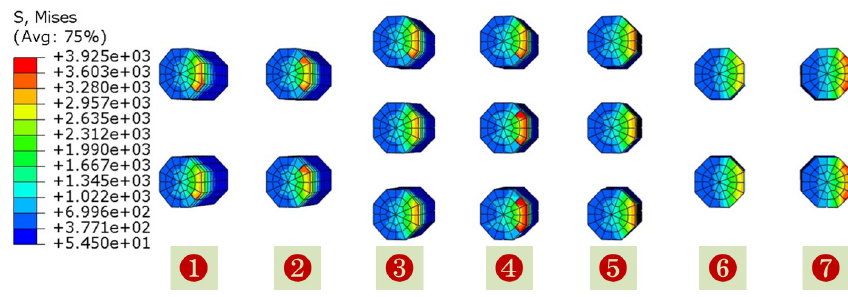
Figure 12. The stress of slip tooth (before optimization).